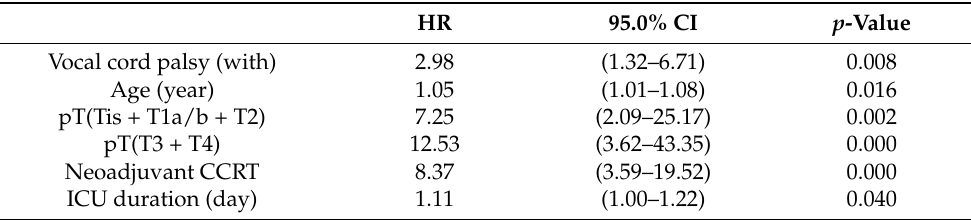
Table 4. Hazard ratios for death (analysis from time of surgery) using the backward elimination (BE). HR 95.0% CI p -Value Vocal cord palsy